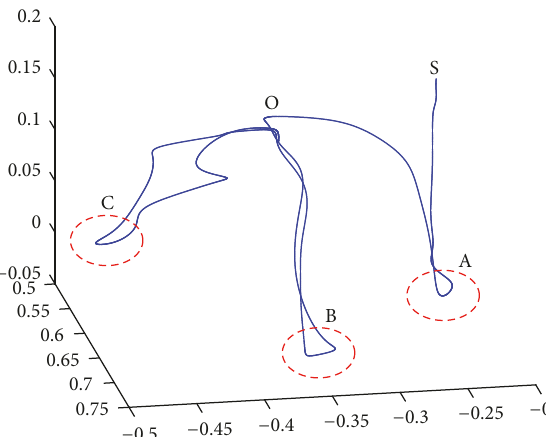
Figure 10: The trajectory of the Baxter robot right arm when accomplishing the learned